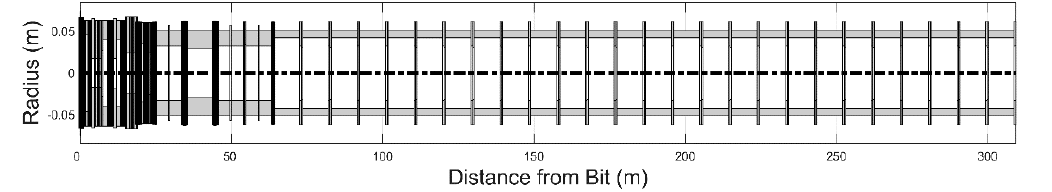
Figure 2. Generic model of a bottom hole assembly (Baker